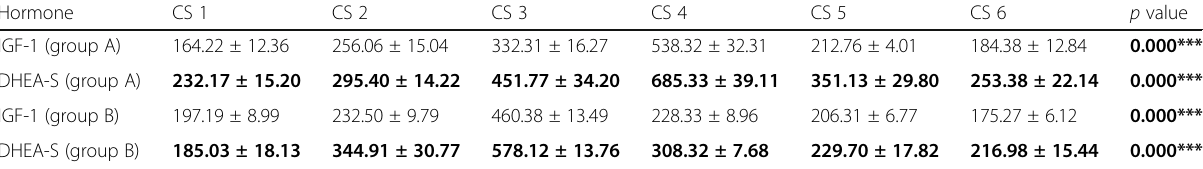
Table 2 Comparison of serum hormone levels within the groups among the CS stages (ANOVA) Hormone CS 1